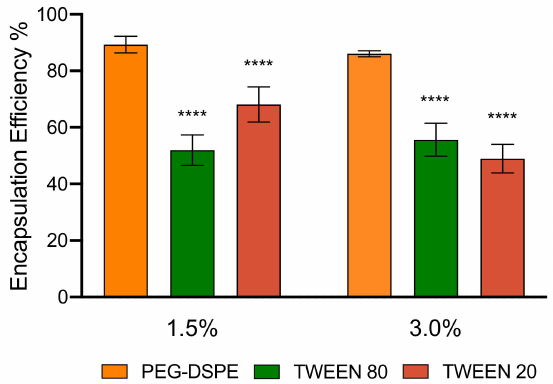
Figure 3. pDNA encapsulation e ffi ciency of LNPs made with 1.5% and 3% of PEG-DSPE, Tween 80 and Tween 20. One-way ANOVA was performed followed by Dunnett’s test for multiple comparisons. **** p <